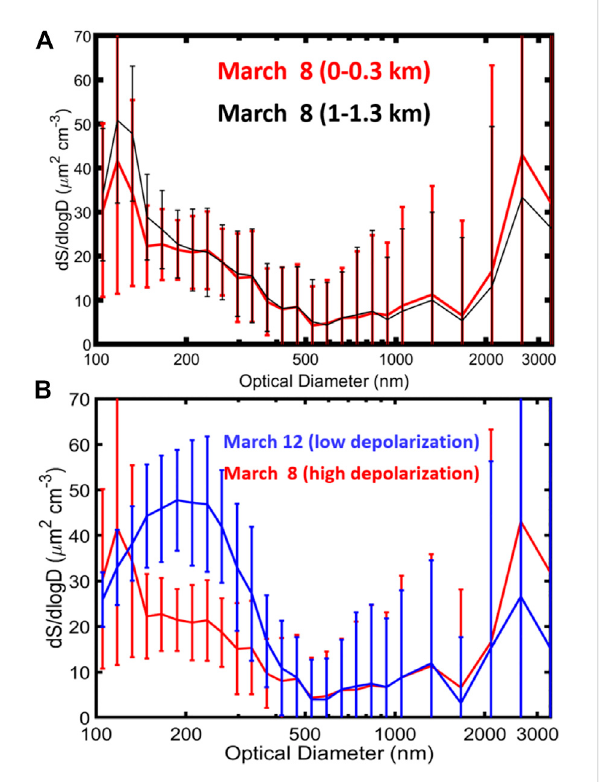
FIGURE 7 (A) Dry surface aerosol size distributions measured between 0 and 0.3 km and between 1 and 1.3 km by the Laser Aerosol Spectrometer (LAS) instrument on board the HU-25 Falcon on 8 March 2020 showing similar dry size distributions near the bottom and top of the marine boundary layer. (B) Dry surface aerosol size distributions measured between 0 and 0.3 km by the Laser AerosolSpectrometer(LAS)instrumentonboardtheHU-25Falconon 8 March 2020 (red) and 12 March 2020 (blue). Note the larger surface area associated with super micrometer particles relative to the fi ne mode particles on 8 March 2020 when HSRL-2 observed elevated depolarization. In contrast, the opposite occurred on 12 March 2020 when HSRL-2 observed low